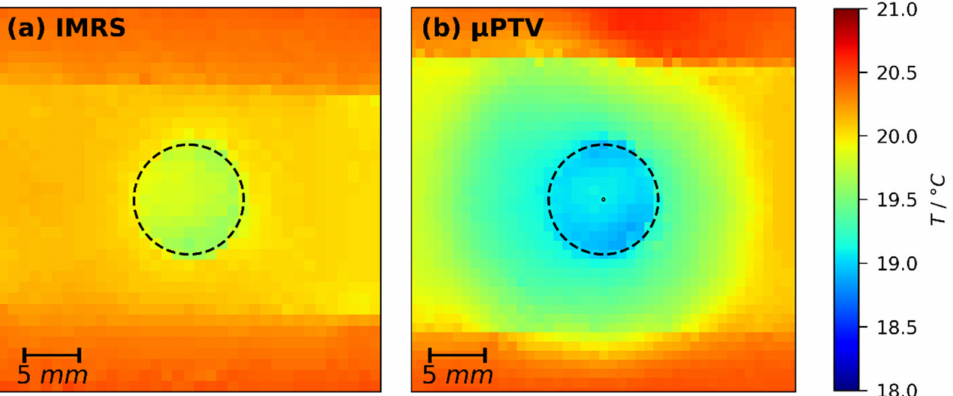
Figure 6. Lateral temperature of poly (vinyl acetate)-methanol films ( X 0 = 2 g h gap = 200 µ m) with substrate set temperature T substrate = 20 ◦ C at t = 20 s drying time (con- stant rate period), measured with a thermal imaging camera. ( a ) IMES; ( b ) µ PTV. The noticeable horizontal stripes are the films and the black dashed circle indicates the lens opening in the metal support. The tiny black circle in ( b ) represents the lateral extent of the 3D- µ PTV